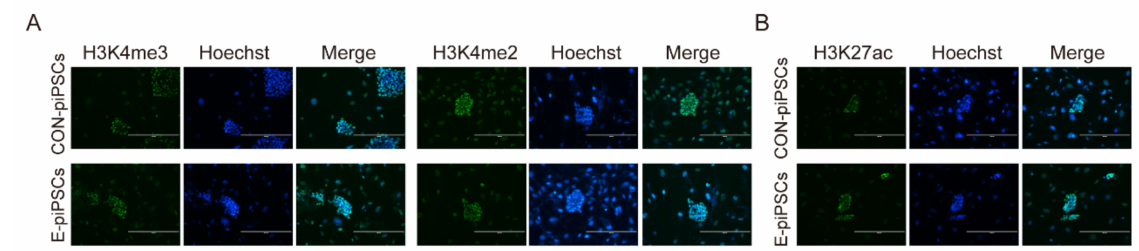
compared to that of CON-piPSCs, and the level of H3K4me2 was slightly reduced in